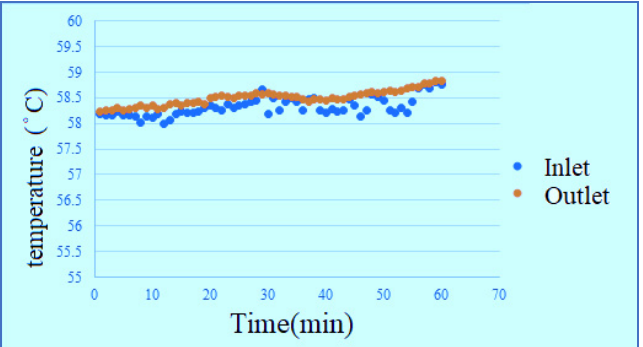
Figure 16. High-temperature low-flow outlet/inlet temperature curve diagram.